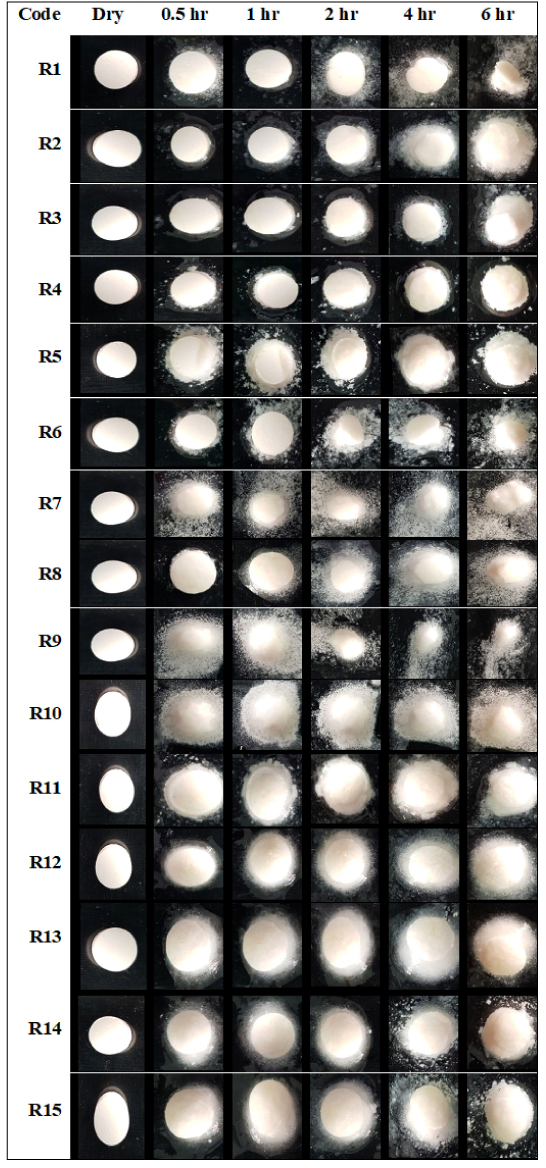
Figure 5. Photographic swelling pattern of the buccal